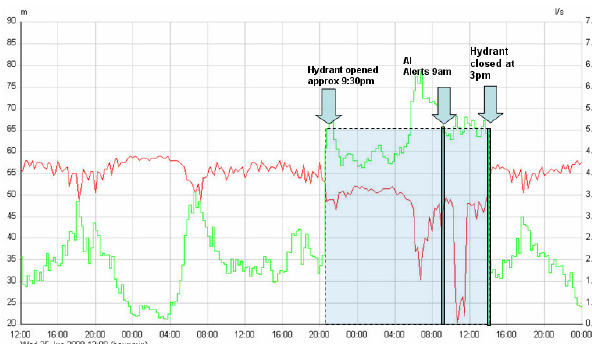
Figure 3. Details of event as reported by Artificial Intelligence based alert